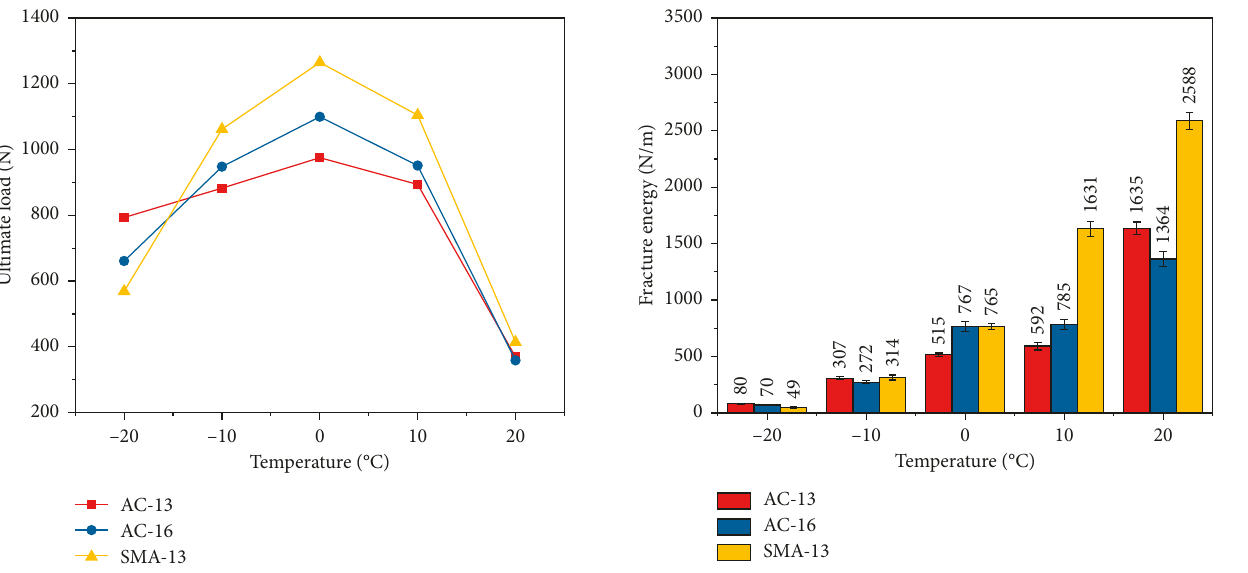
Figure 10: Ultimate loads at different temperatures.